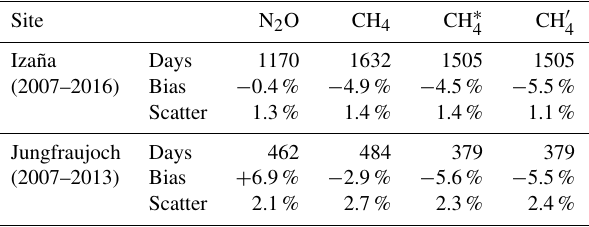
Table 5. Similar to Table 4, but for the difference with respect to GAW data (MUSICA IASI − GAW), for all daily mean data in the 2007–2016 time period and for MUSICA IASI retrievals at